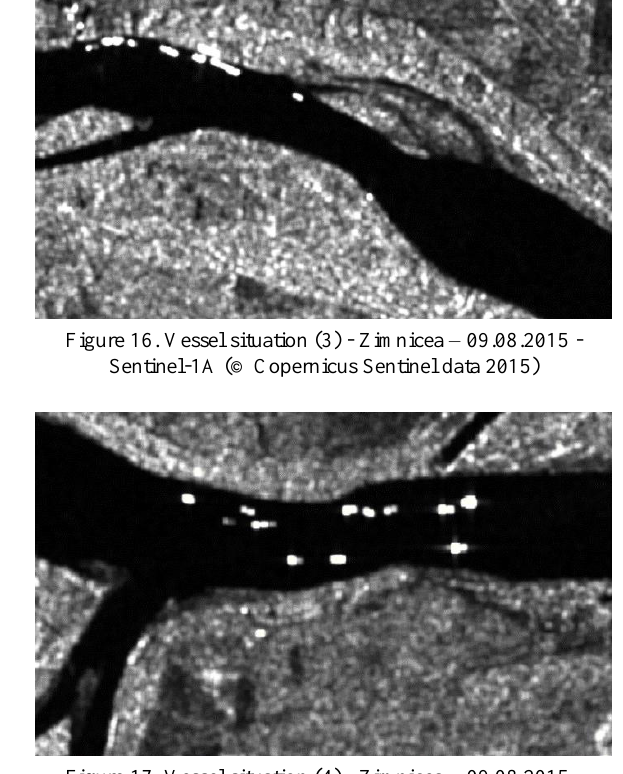
Figure 17. Vessel situation (4) - Zimnicea – 09.08.2015 - Sentinel-1A (© Copernicus Sentinel data